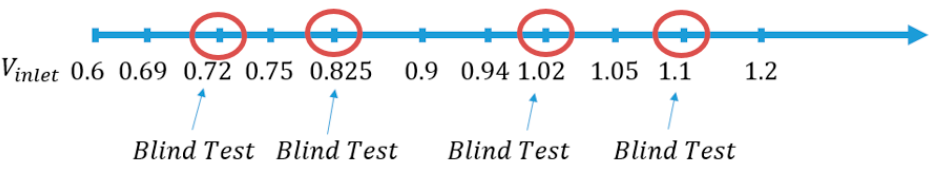
Figure 27. All inlet air velocities used in MFIX simulations along with inlet velocities used in ANN blind test.